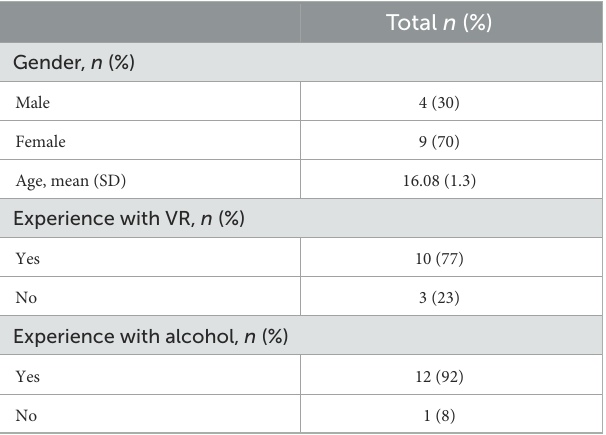
TABLE 3 Characteristics of the study